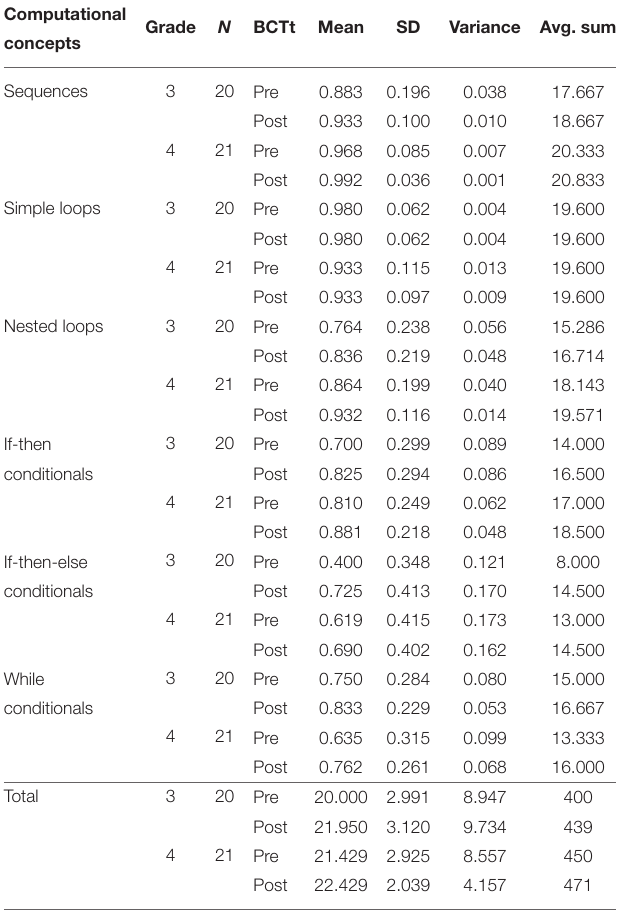
TABLE 3 | Evaluation of computational concepts—Grade 3 and